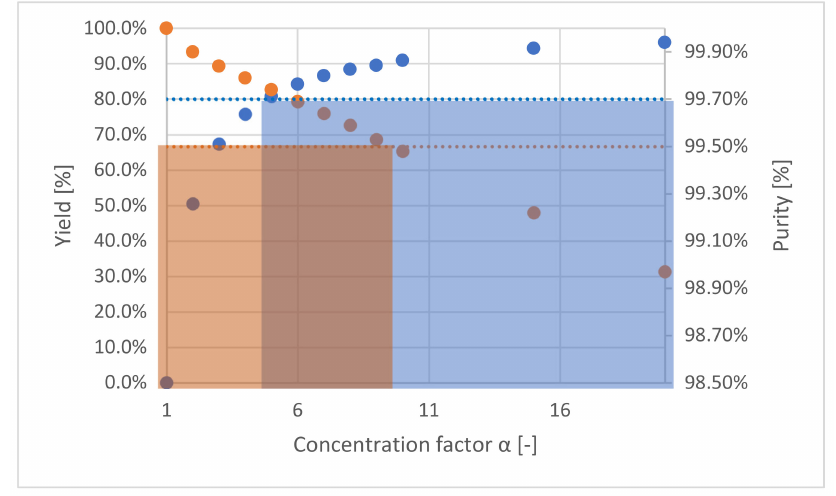
Figure 11. Theoretical definition of a concentration factor range to cover both a requested purity of the final product (orange curve) and a requested yield of the process (blue curve) (from α = 5 ...